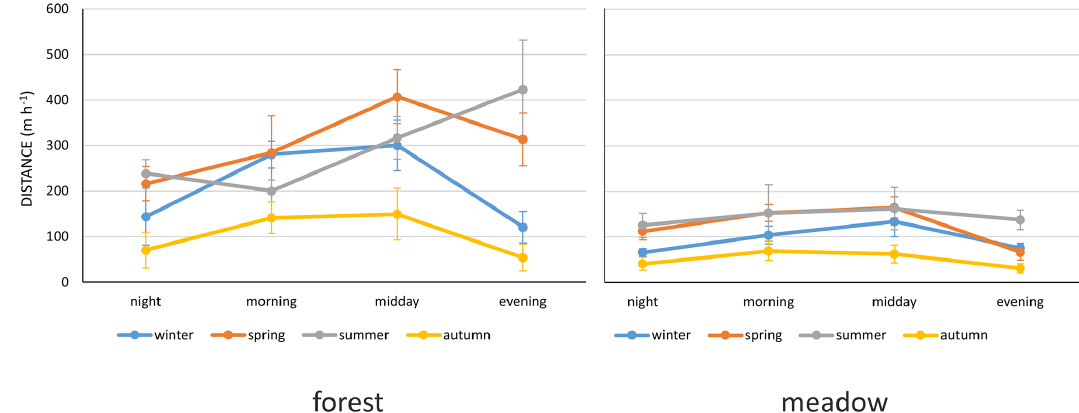
Figure 5. The mean distance (mh − 1 ) travelled by Polish Konik horses during different times of the day and seasons in both habitats.